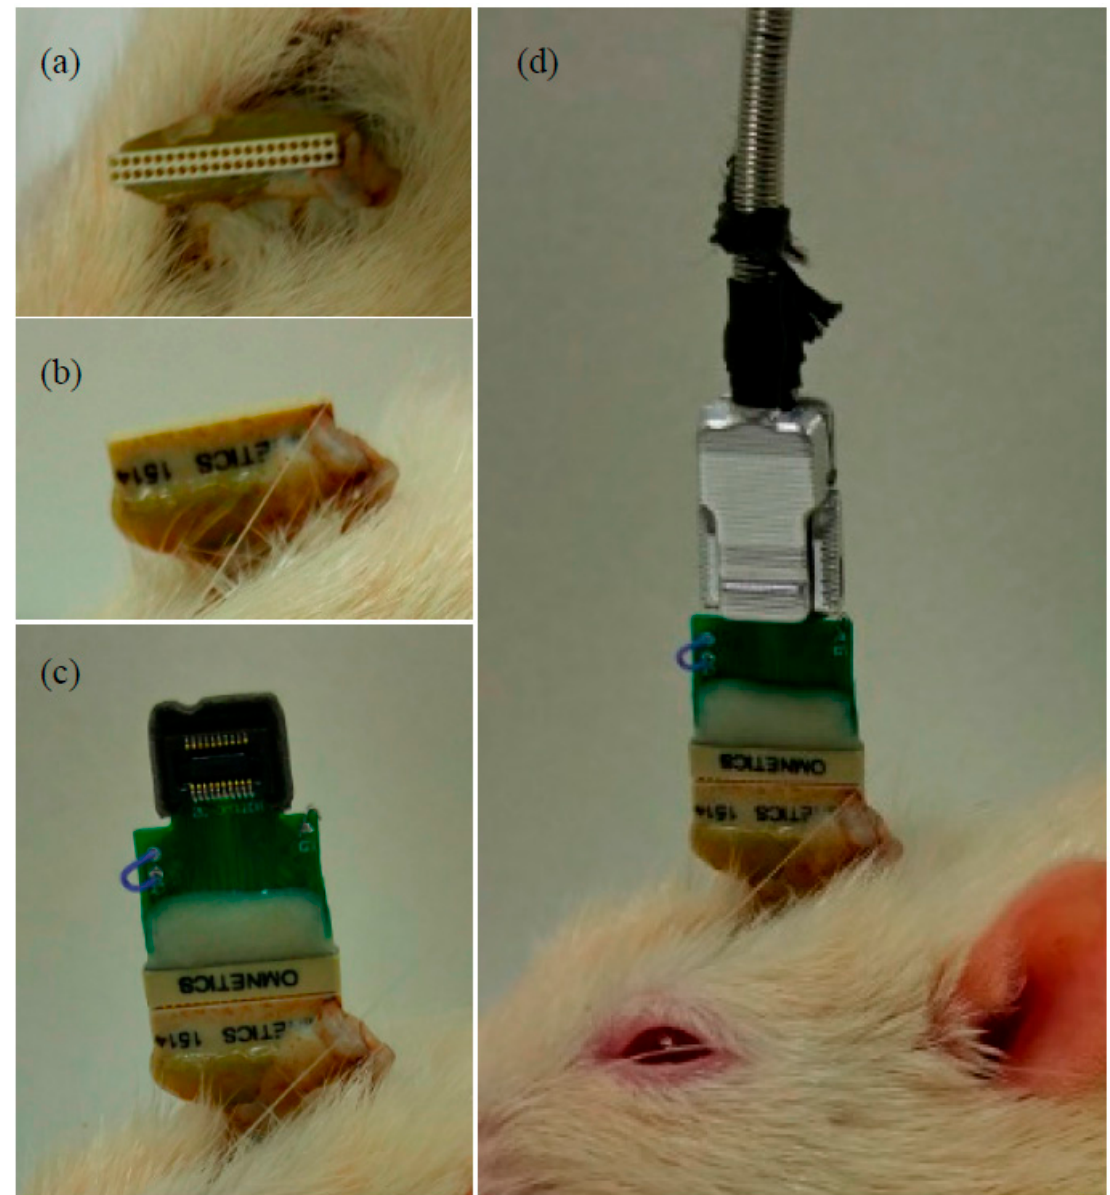
Figure 4. The connection between ECoG electrodes and TDT system. ( a ) A vertical view of an omnectic connector on a rat brain; ( b ) A side view of an omnectic connector on a rat brain; ( c ) Connection of the TDT adapter; ( d ) Connection with TDT zip clip which is connected to TDT acquisition system.